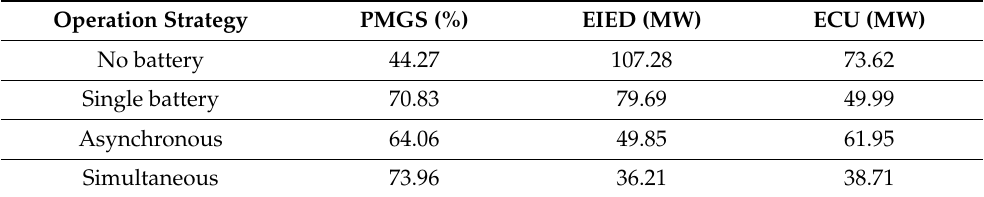
Table 7. The performance indices of BESS-integrated wind farm with 3 MW of battery.